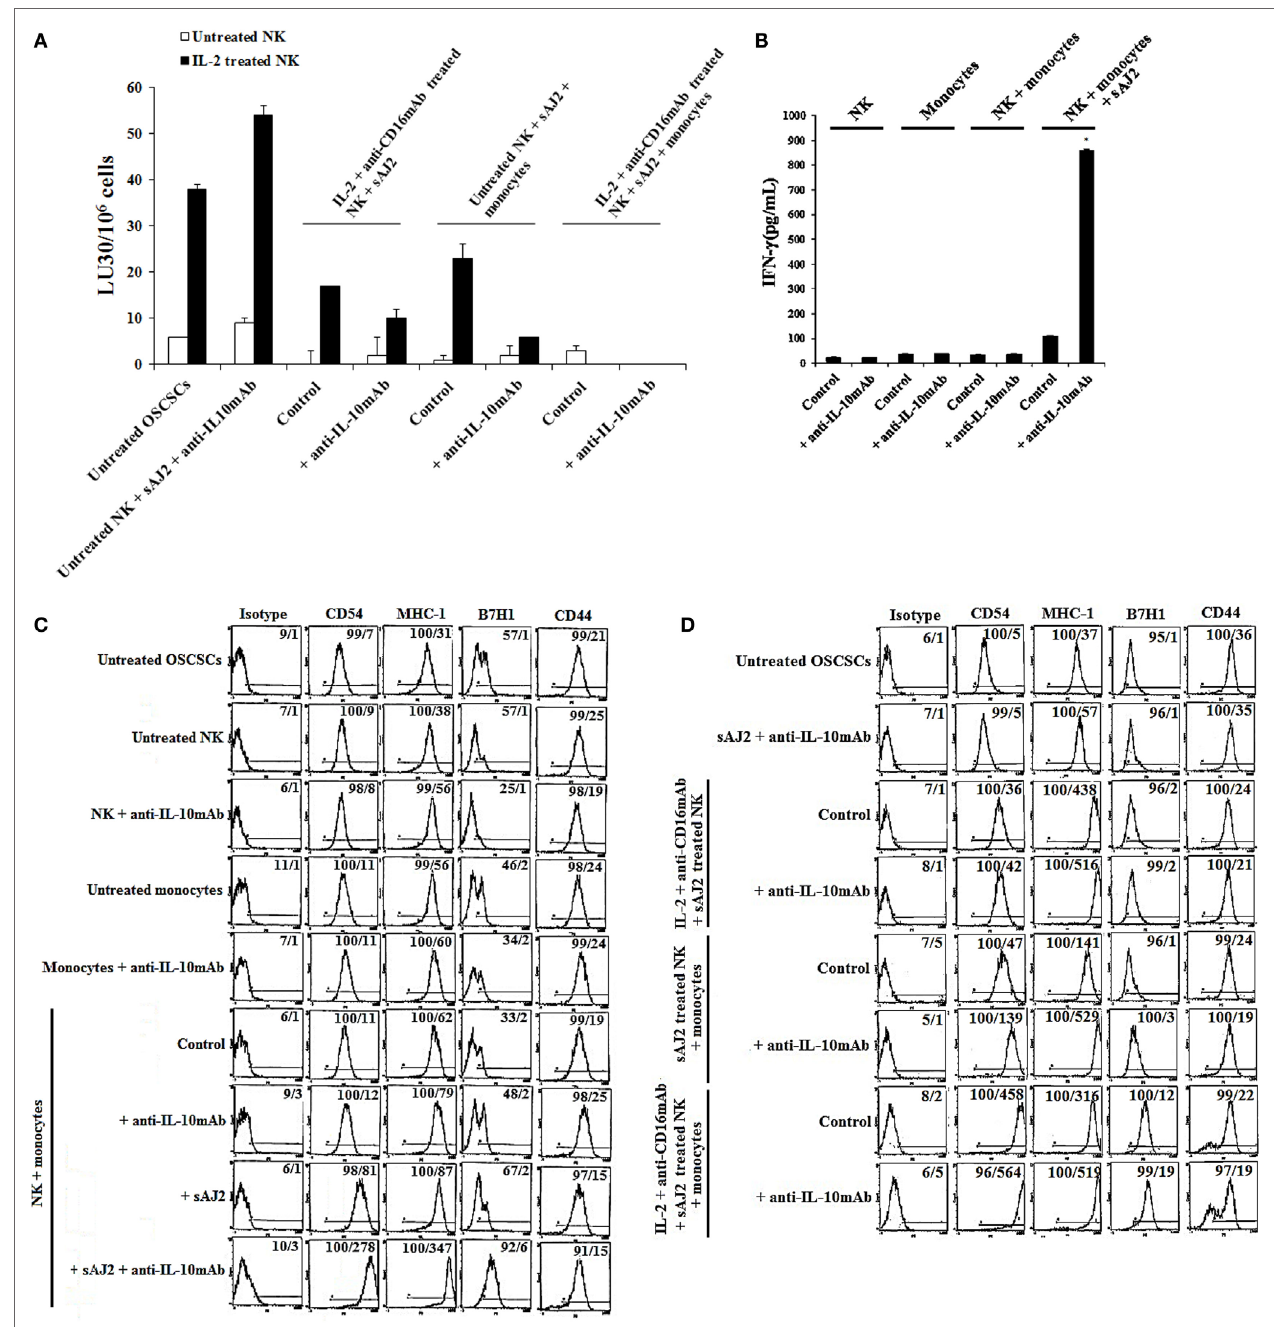
FigUre 5 | il-10 regulation of nK cell mediated csc differentiation in the presence of saJ2 and monocytes is much more pronounced in untreated nK cells when compared to those treated with il-2 and anti-cD16mab . Highly purified NK cells were left untreated or treated with IL-2 (1,000 U/mL) and anti-CD16mAb (3 μ g/mL) with sAJ2 at 1:3 (NK:sAJ2) ratio, monocytes at 1:1 (NK:monocyte) ratio, and/or anti-IL-10 (10 μ g/mL) for 18 h. Afterwards, supernatants were harvested and added to OSCSCs for a period of 3 days. Then, untreated OSCSCs and those treated with NK cell supernatants were detached from the tissue culture plates, washed with 1 × PBS and labeled with 51 Cr. Freshly isolated NK cells were left untreated or treated with IL-2 (1,000 U/mL) for 24 h before the cells were used as effector cells in 51 Cr release assay against OSCSCs. The lytic units 30/10 6 cells were determined using inverse number of NK cells required to lyse 30% of the target cells × 100 (a) . NK cells were prepared as described in (a) , and after an overnight incubation period, the supernatants were harvested, and the levels of IFN- γ secretions were determined using specific ELISAs. Differences between untreated NK cells and those cultured with monocytes and sAJ2 were significant at a P -value of < 0.05 (*) (B) . Untreated NK cells were cultured with autologous monocytes at 1:1 (NK:monocyte) ratio in the presence or absence of anti-IL-10 (10 μ g/mL) and/or sAJ2 at 1:3 (NK:sAJ2) ratio for 18 h. Anti-IL-10 (10 μ g/mL) was added to untreated NK cells and monocytes and used as